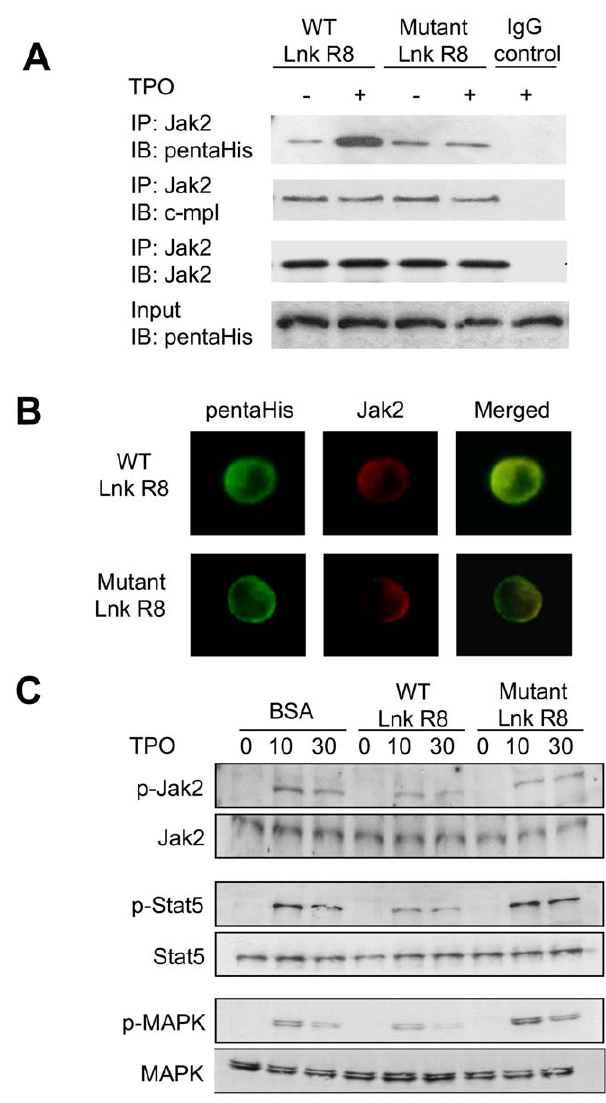
Figure 6. WT Lnk R8 binds endogenous Jak2 and impairs TPO- mediated Jak-Stat and MAPK activation. (A) M-MOK cells treated with WT or mutant Lnk R8 were either stimulated or not stimulated with TPO. Cells were collected and thoroughly washed before lysed. Lysates were immunoprecipitated with anti-Jak2 or control IgG antibody and analyzed by Western blotting with anti-Jak2, anti-pentaHis or anti-c-mpl antibodies. IgG control lane represents immunoprecipitation from WT Lnk R8-treated sample (with TPO stimulation) using control IgG antibody. (B) Protein-treated M-MOK cells were stimulated with TPO for 30 minutes. Cells were fixed and probed with anti-pentaHis and anti- Jak2 antibodies. Secondary Alexa 488 and Alexa 594 conjugated antibodies were used to detect primary antibodies (Green: Lnk R8, Red: Jak2). Co-localization of Lnk R8 and Jak2 (yellow) were shown in merged pictures. (C) Protein treated-M-MOK cells were stimulated with 10 ng/ml of TPO for 0, 10, 30 minutes. Cells were harvested and lysates were subjected to Western blot analyses. Phosphorylation and total protein levels of Jak2, Stat5 and MAPK were detected using antibodies as described in Materials and Methods. Figure 7. TG101348 and PD98059 suppress TPO-induced (MAPK inhibitor) or inhibitor solvent DMSO for 1 hour in RPMI with 10% FCS before TPO addition. Each day cell count was performed to check cell number. DMSO has no effect on TPO- induced cell proliferation (Figure 7). In contrast, TG101348